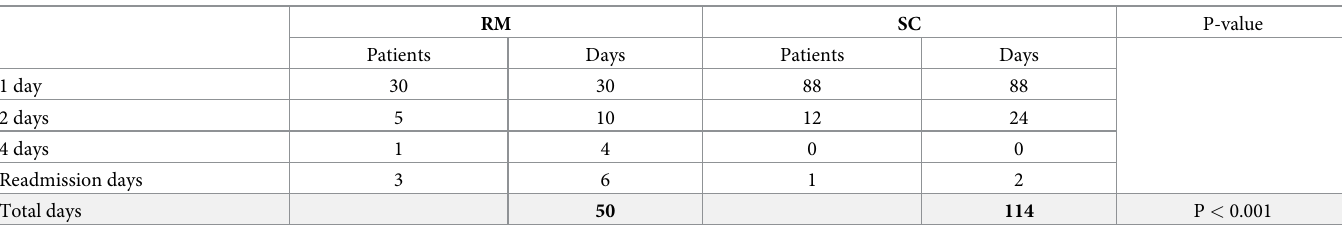
Table 3. Hospitalization